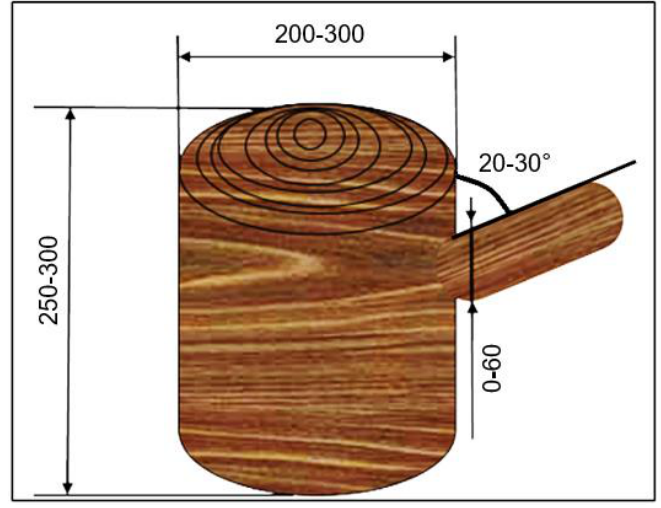
Figure 4. Material sample of Norway spruce.